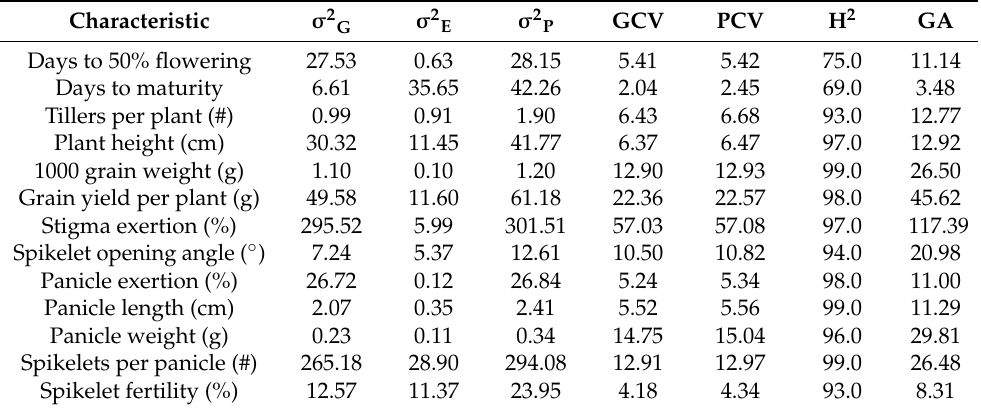
Table 3. Variance components and genetic parameters of agronomic and floral traits of 216 maintainers and two